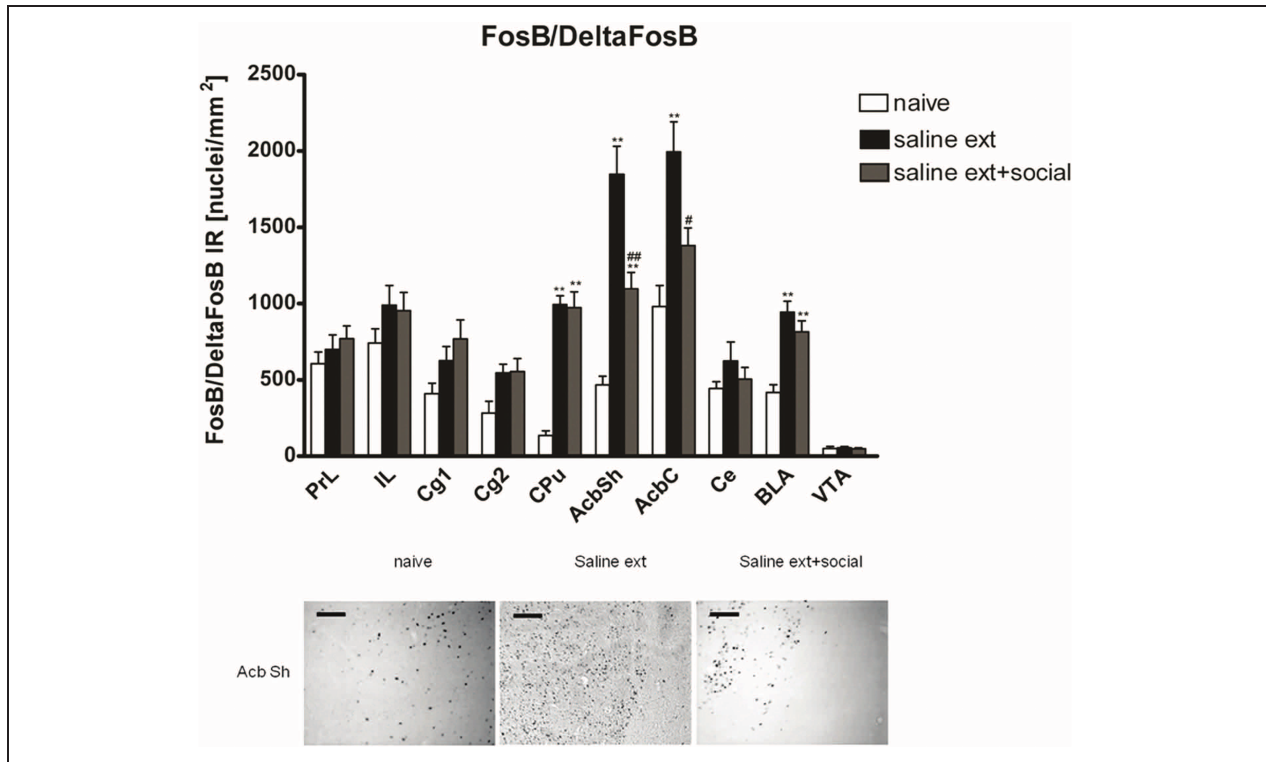
FIGURE 2 | Social interaction decreases cocaine CPP reinstatement-associated FosB/ (cid:2) FosB expression in nucleus accumbens shell and core. Shown are FosB/ (cid:2) FosB positive immuno-reactive nuclei per mm 2 of the respective brain area. Shown are group means ± SEM. ∗∗ P < 0 . 01 compared to naive group; # P < 0 . 05 and ## P < 0 . 01 compared to saline extinction group. In the dorsal striatum (CPu) and the basolateral amygdala (BLA), priming with cocaine after saline or saline + social extinction increased FosB/ (cid:2) FosB expression in